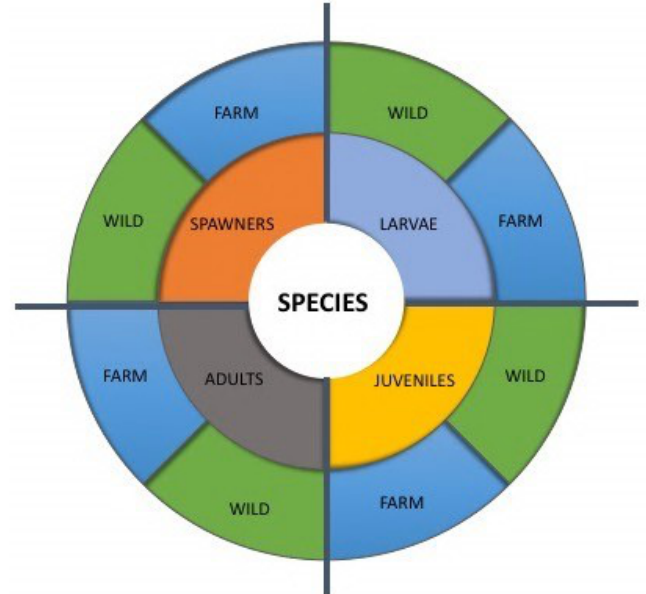
Figure 1. Logic and organization of the entries in the Short Profiles. Each species is divided into four main life stages (larvae, juveniles, adults and spawners), corresponding to four production stages (hatchery, nursery, grow-out and broodstock). For each of these, the entries provide information from the wild and under farming conditions (see text for details).